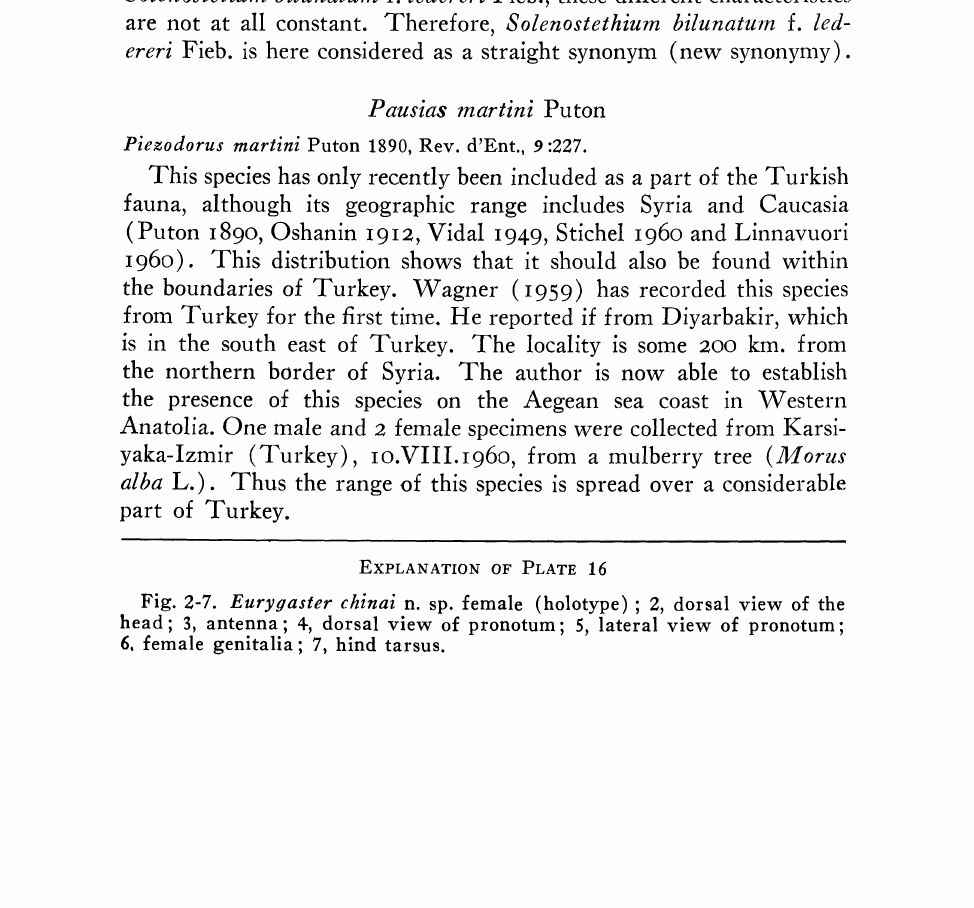
Fig. 2-7. Eurygaster chinai n. sp. female (holotype) 2, dorsal view of the head; 3, antenna; 4, dorsal view of pronotum; 5, lateral view of pronotum; 6. female genitalia; 7, hind